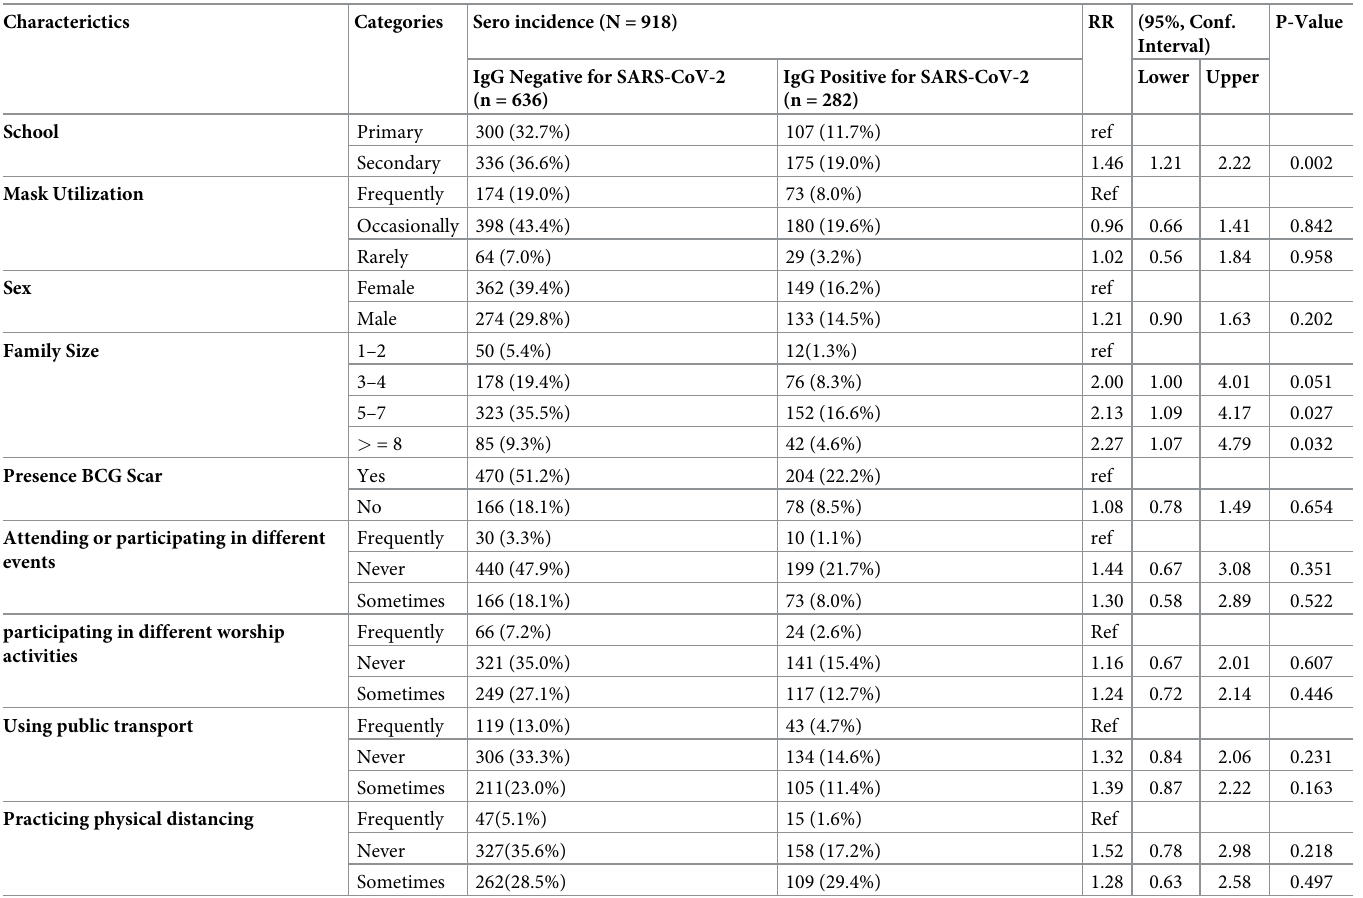
Table 3. Multiple logistic regression of SARS-CoV-2 and association with seroincidence, December 2020 to April 2021.